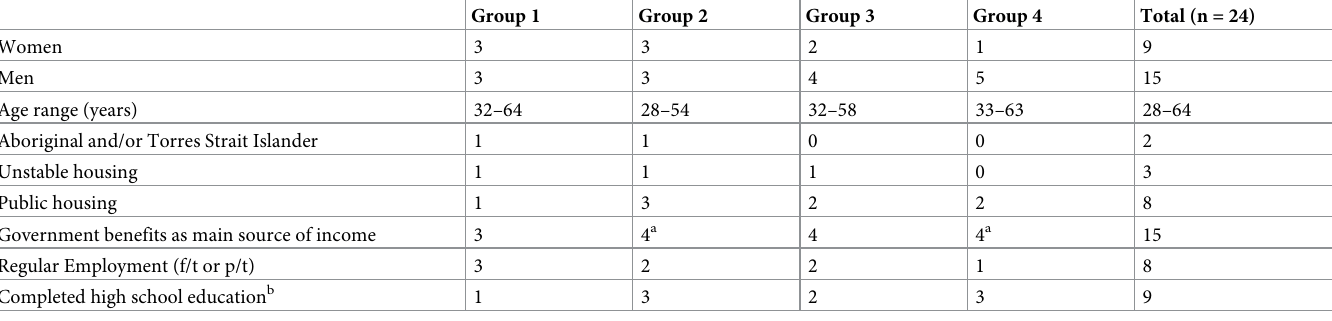
Table 1. Demographic characteristics of participants by group (total n = 6 participants per